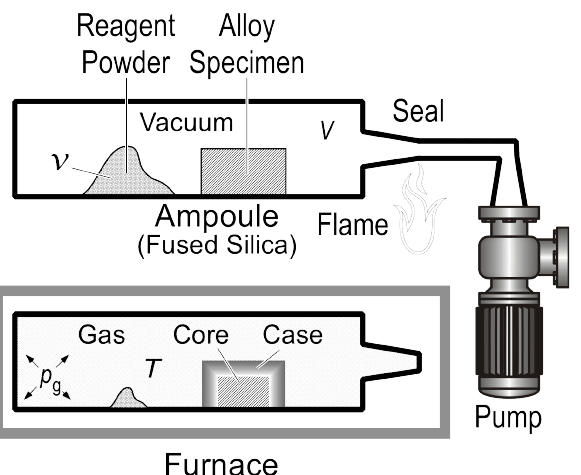
Figure 1. Concept of low-temperature nitrocarburization of alloys by closed-vessel reagent pyrolysis, the “Encapsulation Method” [22].